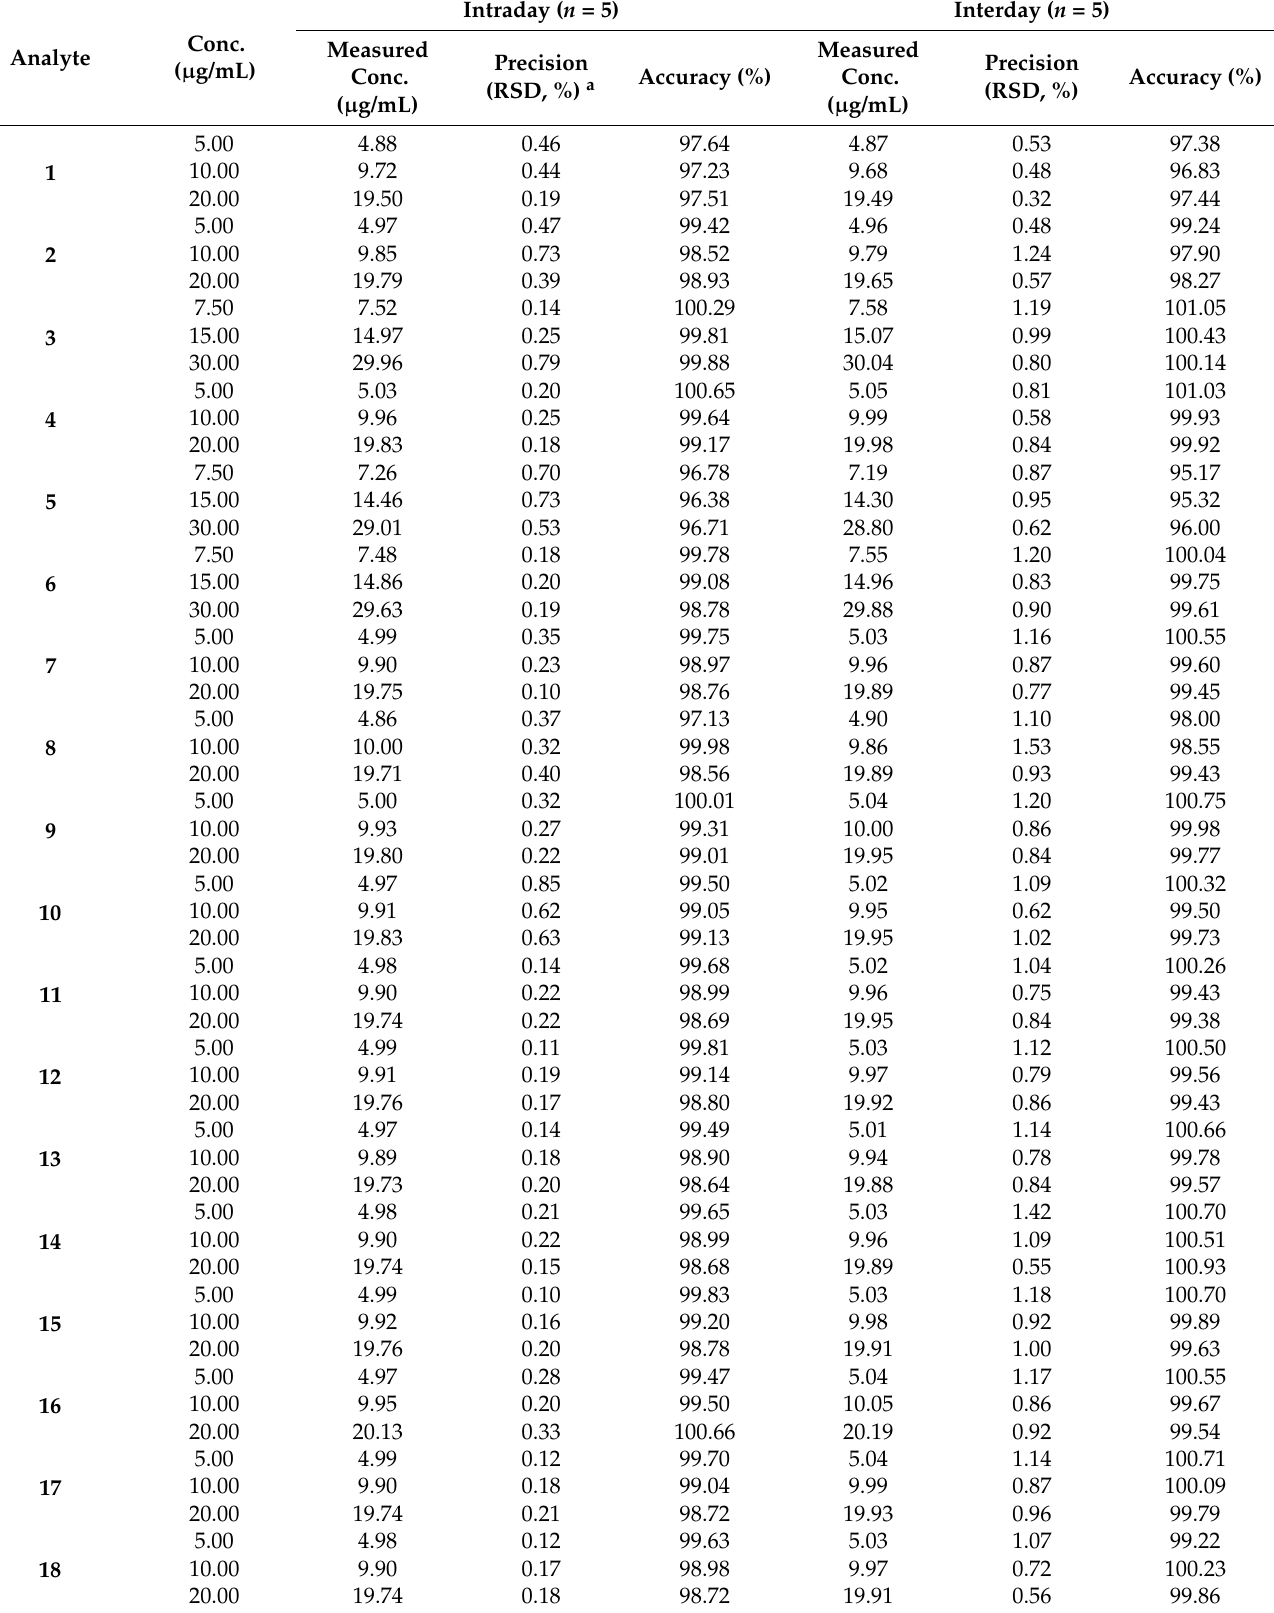
Table 3. Precision and accuracy of the developed analysis method using 24